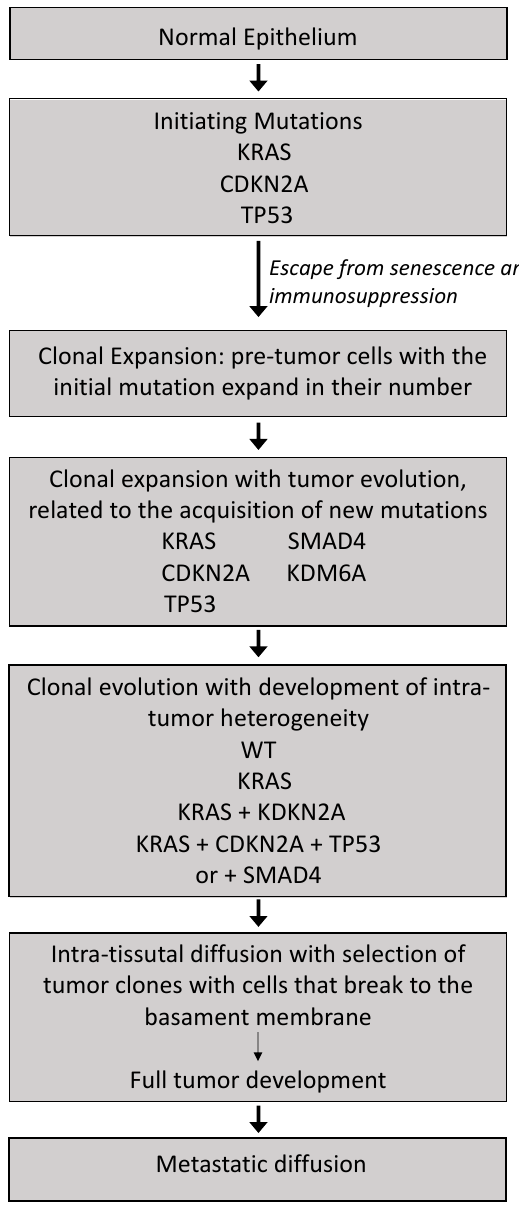
Figure 2. Various stages of pancreatic cancer evolution. The various stages of pancreatic cancer evolution are outlined, together with the main genetic alterations occurring at these stages.